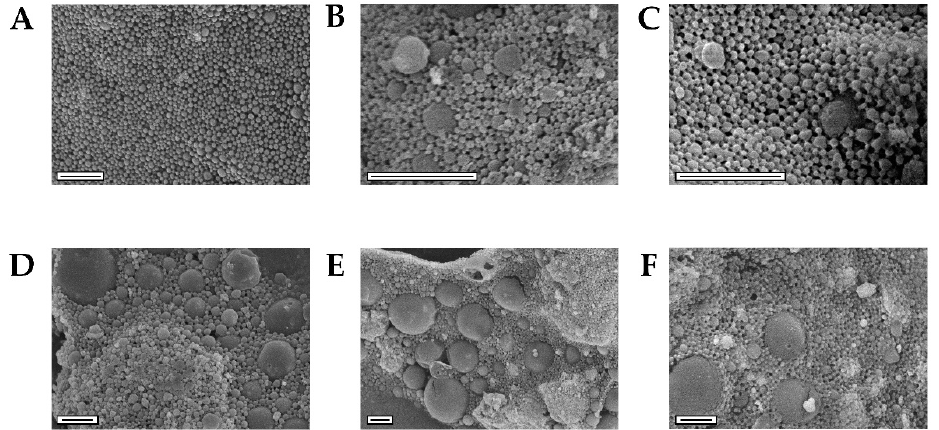
Figure 2. SEM images highlight the size uniformity of NEMO particles compared to NEIO particles. MnO NPs were encapsulated in PLGA with either ( A ) 0%, ( B ) 2.5%, or ( C ) 5% ( w / w ) PLGA-PEG. Similarly, Fe 3 O 4 NPs were encapsulated in PLGA with either ( D ) 0%, ( E ) 2.5%, or ( F ) 5% PLGA-PEG. NEMO particles were observed to have a spherical shape with near uniform size distribution for all samples. NEIO particles were also observed to have a spherical shape but possessed a heterogenous size distribution for all samples. Scale bars are 1 µm.